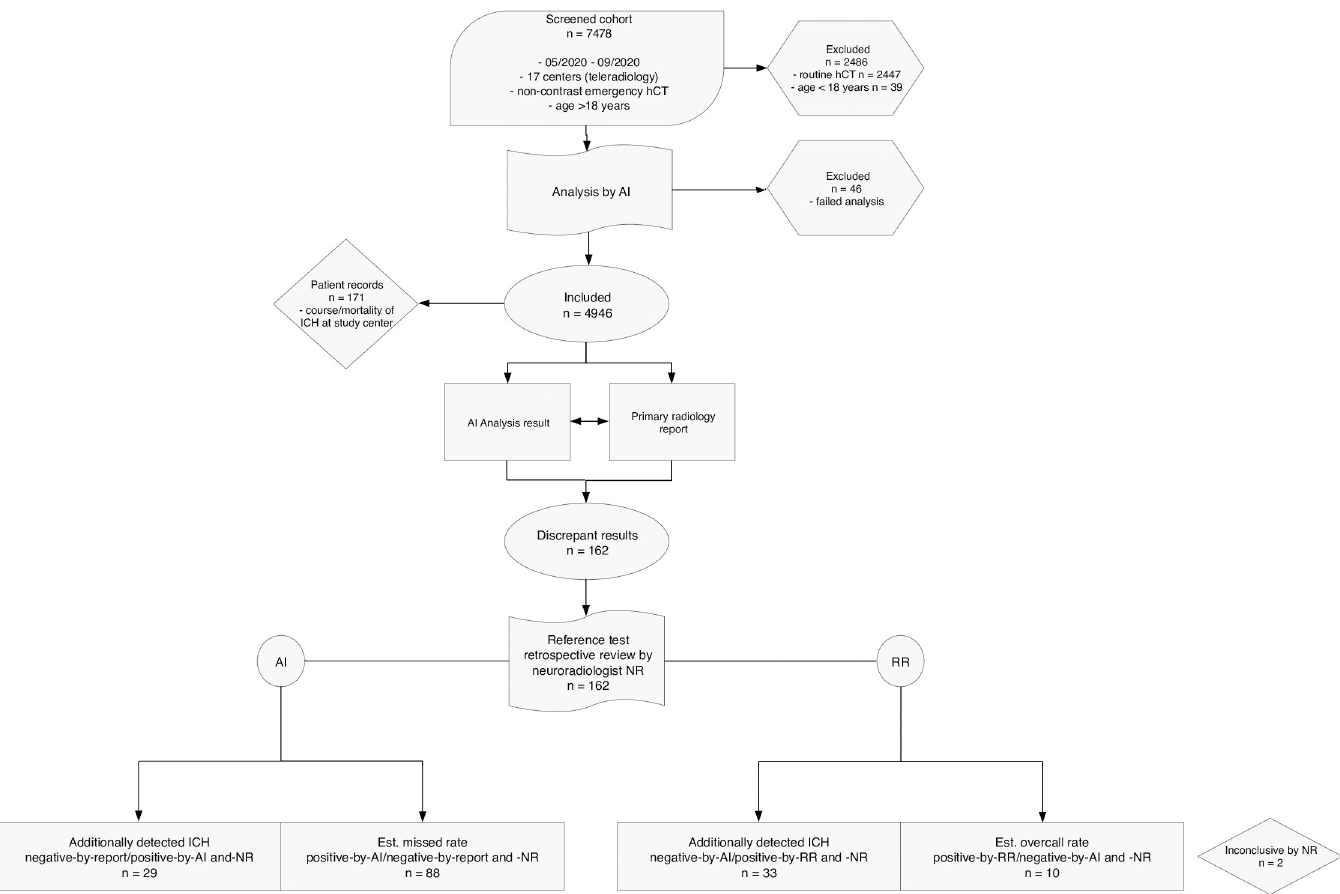
Fig 1. Study protocol. Study protocol and conduct followed STROBE-Initiative guidance and describes: patient screening; inclusion and exclusion criteria; comparison of primary RR and AI analysis results with the reference standards, i.e. review by a neuroradiologist (STROBE, Strengthening the Reporting of Observational Studies in Epidemiology; AI, artificial intelligence; RR, radiology